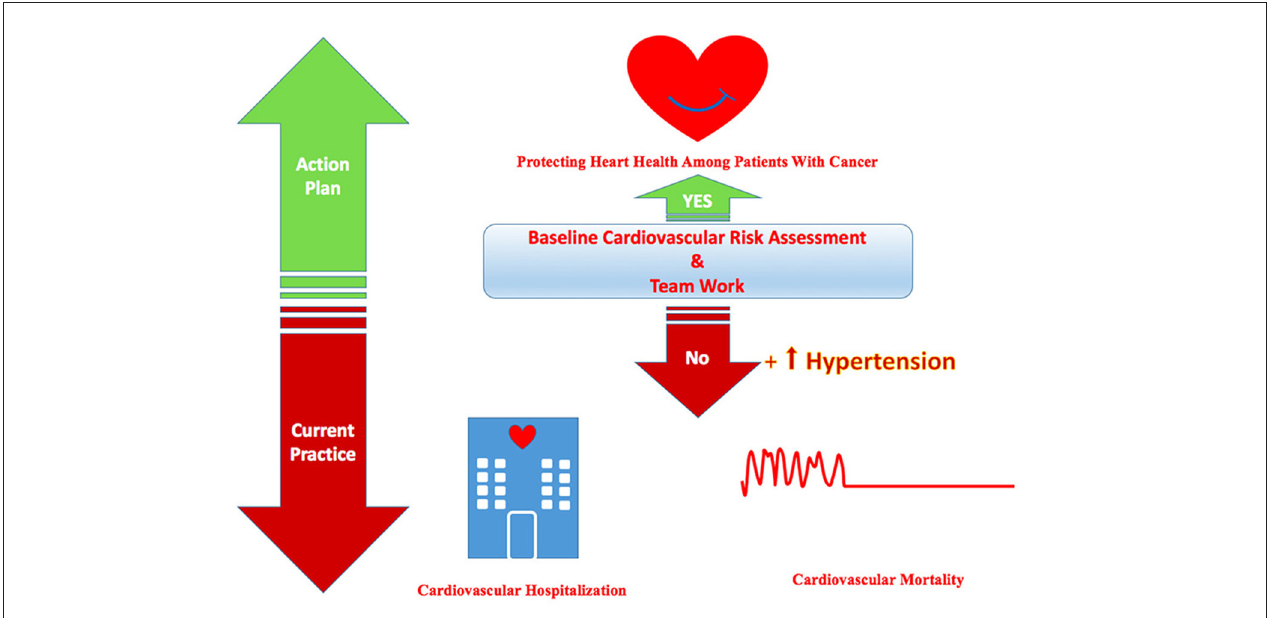
FIGURE 7 | Central illustration showing the current practice and the required action plan to protect heart health among patients with cancer. Hypertension is the most common baseline cardiovascular risk factor among cancer patients according to the current practice which can be the leading cause of cardiovascular hospitalization and mortality. The action plan is required to protect the heart health of cardio-oncology patients by baseline cardiovascular risk assessment and